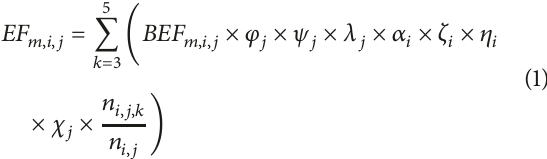
Idling Time Proportion (%)